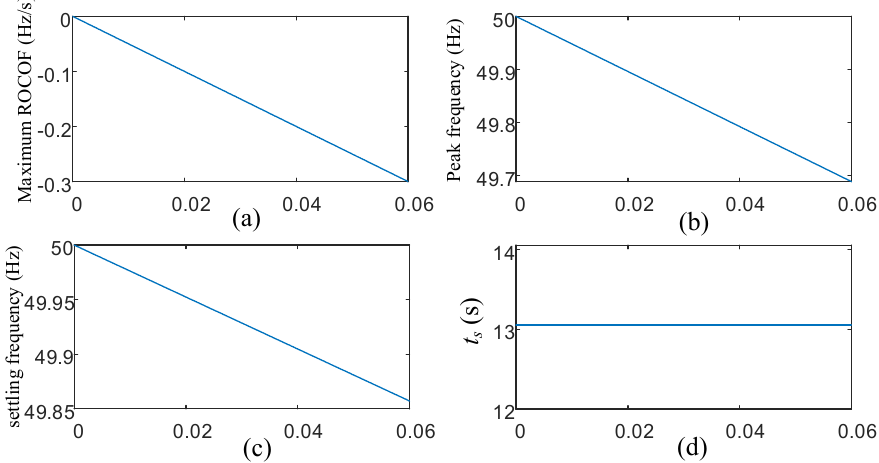
Figure 6. The influence of load deviation on performance indices: ( a ) maximum ROCOF, ( b ) peak frequency, ( c ) settling frequency, and ( d ) settling time.